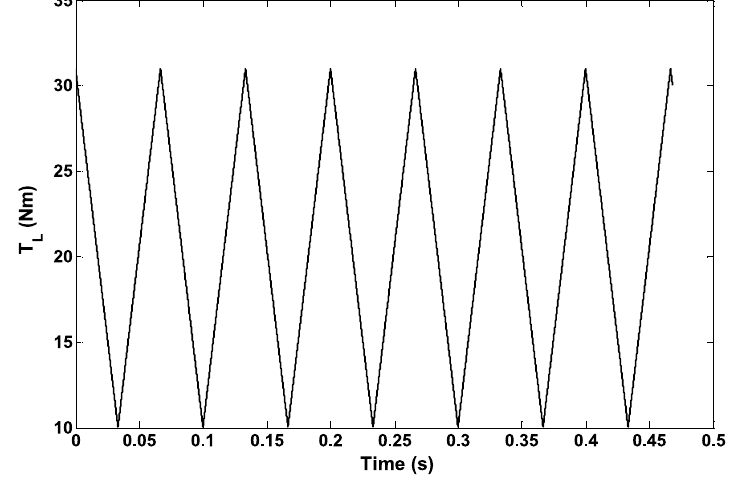
Fig. 6. Evolution of the load applied on the inertia wheel 22.